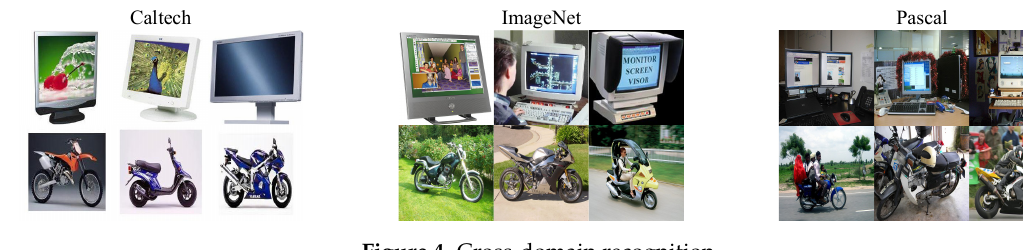
Figure 4. Cross-domain